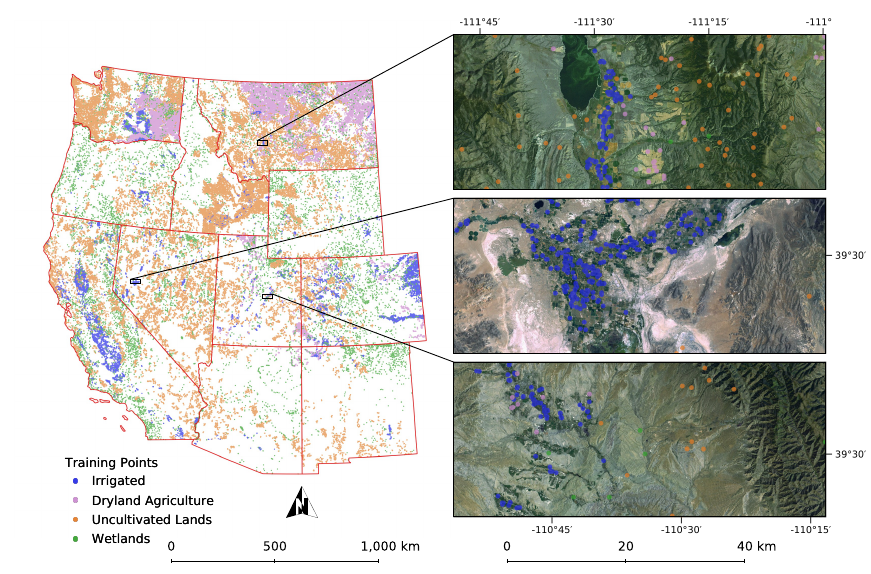
Figure 5. Training data sample points from the four classes used to train IrrMapper (i.e., irrigated, wetland, dryland agriculture, and uncultivated). Points were randomly sampled from within a 20-m interior buffer of the training data GIS